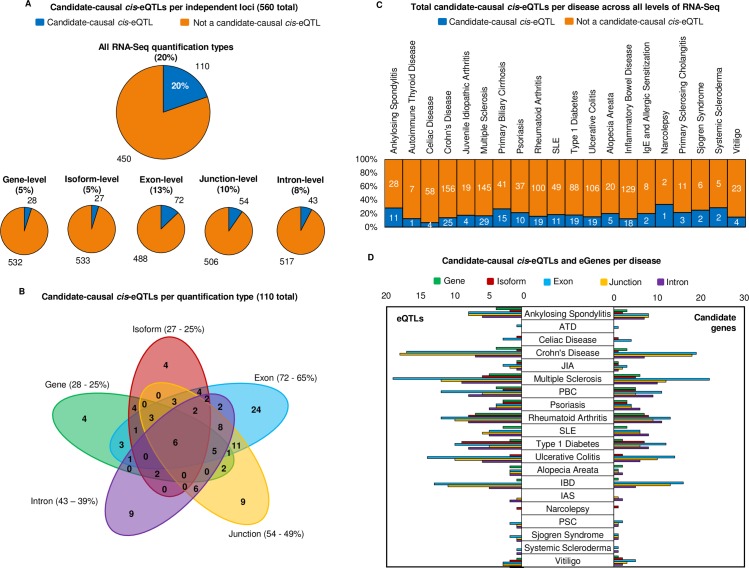
Breakdown of autoimmune associated causal cis-eQTLs using RNA-Seq.(A) Percentage and number of causal cis-eQTL associations detected per RNA-Seq quantification type, following LD pruning of associated SNPs from twenty autoimmune diseases to 560 independent susceptibly loci. The top chart shows the number of causal cis-eQTLs when combining all RNA-Seq profiling types together (20%). (B) Sharing of causal cis-eQTL associations per quantification type (110 detected in total). Percentage of causal cis-eQTLs captured are shown as a percentage of the 110 total. (C) Total causal cis-eQTLs per disease across all five levels of RNA-Seq quantification, using the 20 diseases of the ImmunoBase resource. In orange are disease-associated SNPs that show no shared association with expression across any quantification type. In blue are the disease-associated SNPs that are also causal cis-eQTLs. (D) Causal cis-eQTLs and candidate genes per disease broken down by quantification type.